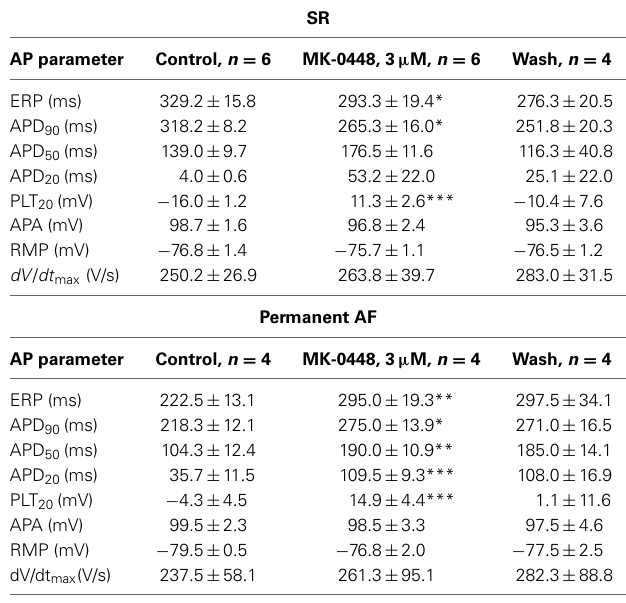
Table 3 | Effects of MK-0448 (3 µ M) on action potential parameters and effective refractory period (ERP) of human right atrial trabeculae from patients in SR and AF (stimulation frequency 1Hz).